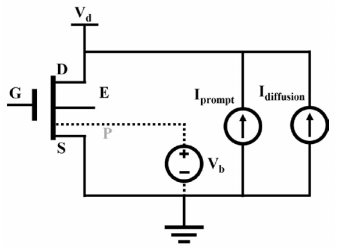
Figure 3. The equivalent circuit model of the SET